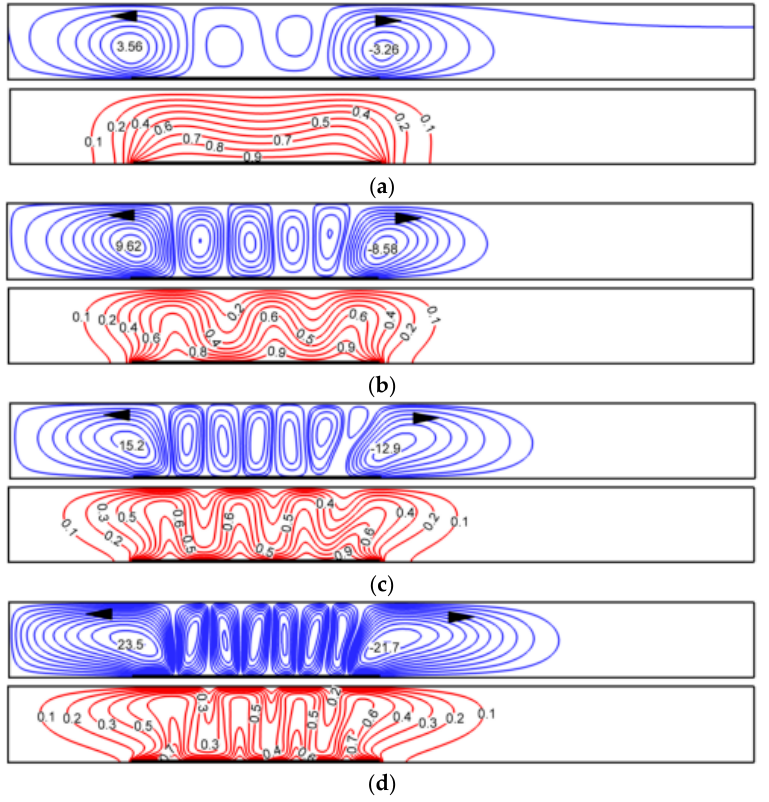
Figure 2. Streamlines (above) and isotherms (below) profiles for different Ra numbers and Pe = 0.5, ( c = 0.33 ) , ( a ) Ra = 100, ( b ) Ra = 250, ( c ) Ra = 500, ( d ) Ra = 1000